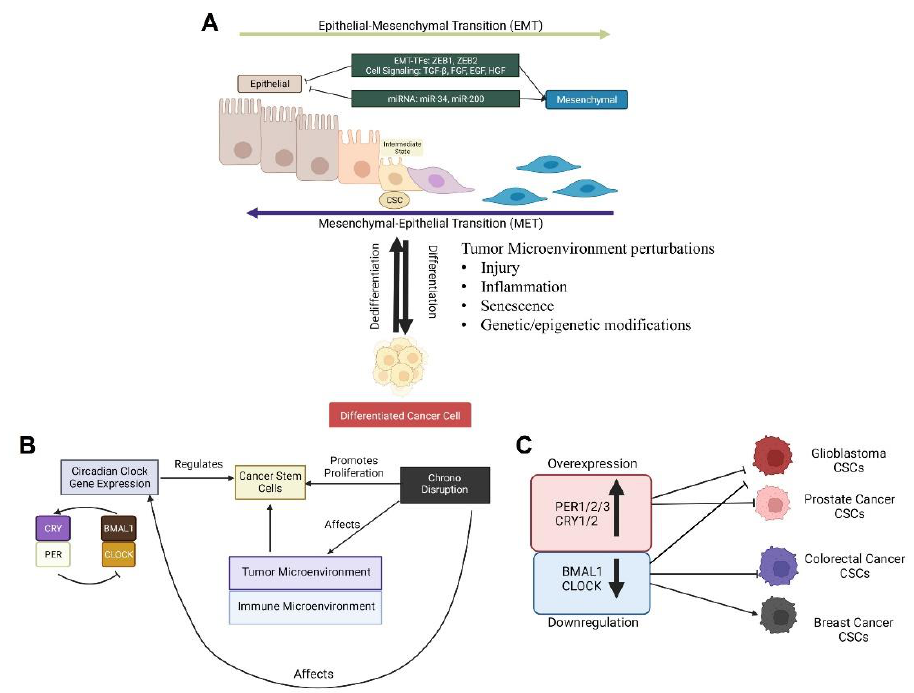
Figure 2. Role of the circadian clock in cancer stem cell plasticity and maintenance. ( A ) The generation and maintenance of cancer stem cells (CSCs) is associated with cellular plasticity in that the cells remodel themselves from a stem cell state (epithelial) into a differentiated state during a process called the epithelial–mesenchymal transition (EMT), according to tumor-microenvironmental changes. ( B ) Diagram showing the regulatory influences of molecular clock functions and circadian disruptions on CSC development. Circadian disruptions (e.g., chronic jet lag) remodel the tumor-immune microenvironment to favor the proliferation of CSCs. In turn, changes in the tumor microenvironment can alter circadian clock functions that contribute to the differentiation of cancer stem cells into malignant cancer cells. ( C ) Down-regulation of the BMAL1/CLOCK circadian activator complex or overexpression of the period genes (e.g., PER2 and PER3) inhibits CSC maintenance and survival in multiple types of cancers. One notable exception is a breast cancer stem cell model in which CLOCK repression was shown to increase tumor cell growth.